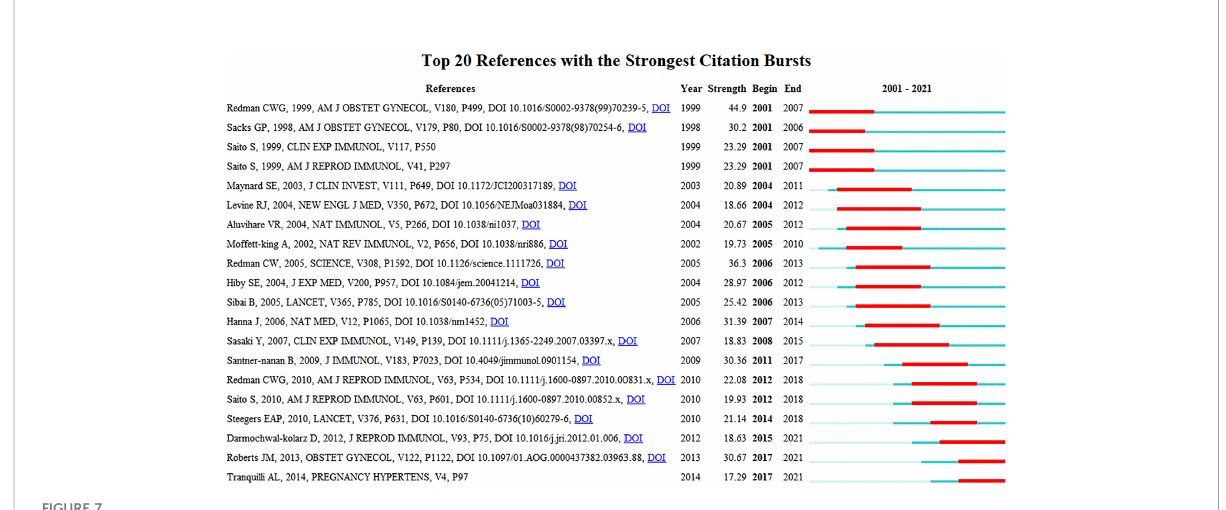
FIGURE 7 Mutation detection of co – citation analysis (outbreak durations ≥ 4